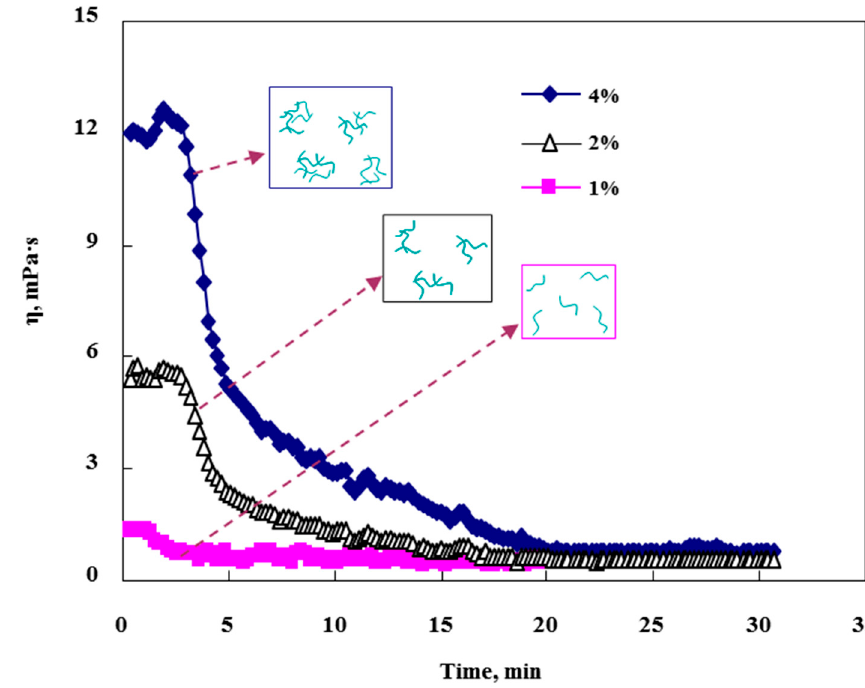
Table 2. Fitting results of rheological behavior at different VES concentration.